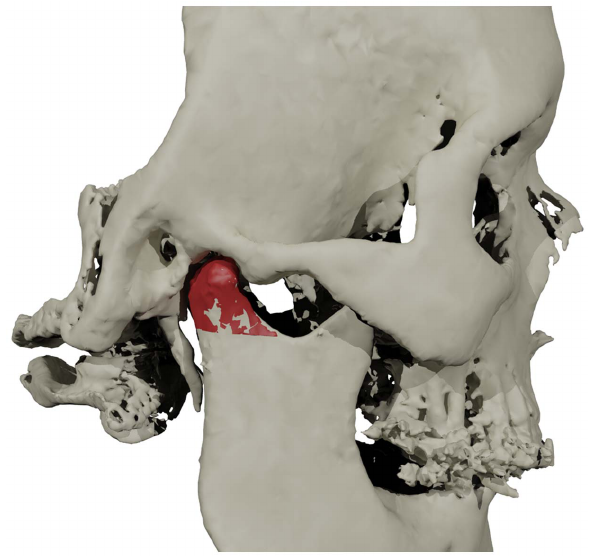
Figure 4. The 3D reconstruction of semi-automatically seg- mented condyle (red), and its integration into the original 3D virtual head model of Figure 1. Condylar measurements can be carried out using this integrated